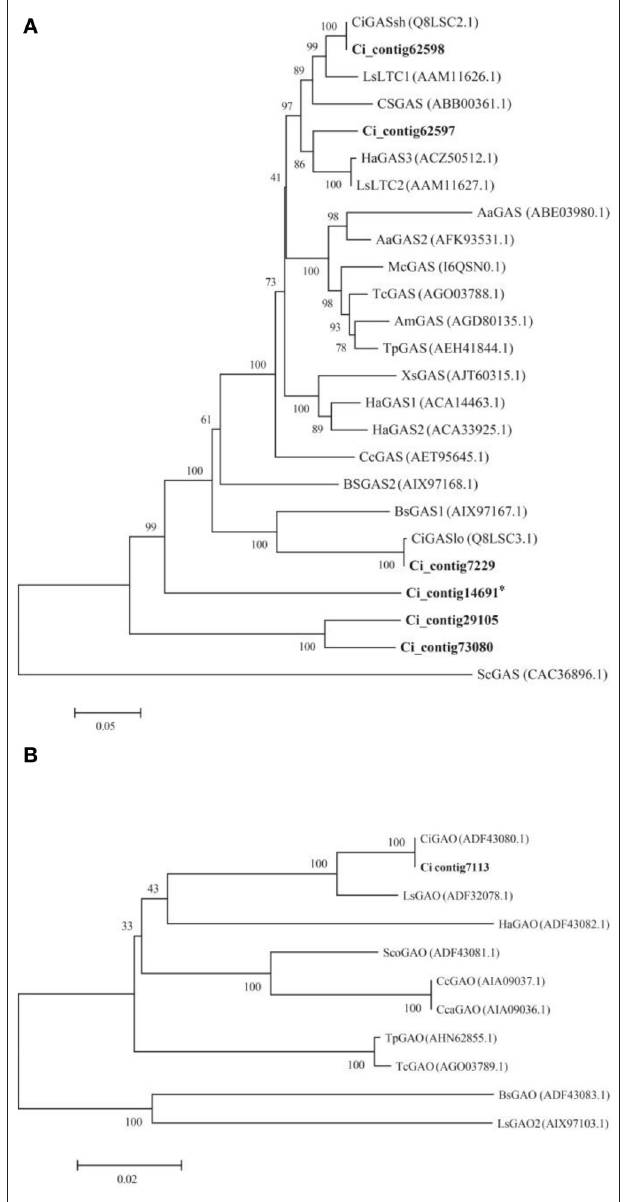
FIGURE 6 | Phylogenetic analysis of C. intybus GAS and GAO deduced proteins. The trees were inferred with the neighbor-joining method. Bootstraps values (at the branching points) are given for major nodes and are based on 1000 replicates. The length of the lines indicates the relative distances between nodes. Putative proteins identified from C. intybus assembled transcriptome are in bold. GenBank accession numbers are shown in parentheses. (A) Phylogenetic tree of GAS proteins from Asteraceae species. Asterisk indicate a partial deduced product. (B) Phylogenetic tree of GAO proteins from Asteraceae species. Aa, Artemisia annua ; Am, Achillea millefolium ; Bs, Barnadesia spinosa ; Cc, Cynara cardunculus var. scolymus ; Cca, Cynara cardunculus var. altilis ; Ci, Cichorium intybus ; Cs, Crepidiastrum sonchifolium ; Ha, Helianthus annuus ; Ls, Lactuca sativa ; Mc, Matricaria chamomilla var. recutita ; Sc, Solidago canadensis ; Sco, Saussurea costus ; Tc, Tanacetum cinerariifolium ; Tp, Tanacetum parthenium ; Xs, Xanthium strumarium